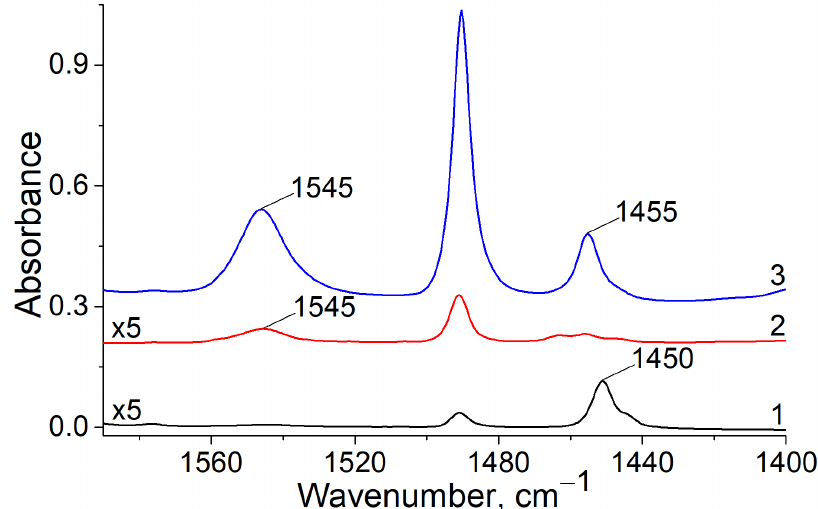
Figure 4. FTIR spectra of Sn-BEA (1), DeAl-BEA (2), and BEA (3) following the Py adsorption; spectra are offset for clarity.